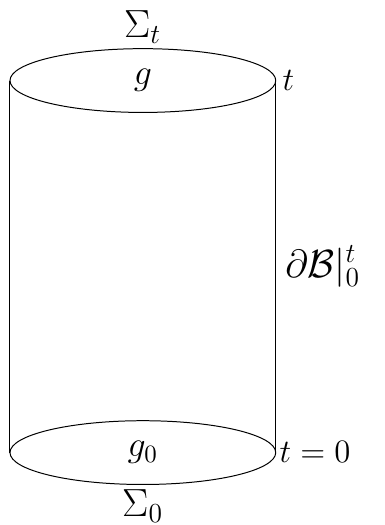
JHEP03(2023)026 (b) The shaded region represents the gravitational (a) This hollow figure represents the partition func- path integral (in eq. (7.7)) over the space-filling tion Z [ g, t ; g bdy ; g 0 , 0] (in eq. (7.6)) of the field the- manifolds whose boundary is ∂ M = Σ t ∪ ∂ B| t ∪ ory on ∂ M = Σ t ∪ ∂ B| t ∪ Σ 0 . The metric on Σ 0 is 0 0 Σ 0 . The bulk metric g satisfies Dirichlet boundary g 0 , on Σ t is g and on ∂ B| t is g bdy . 0 condition (i.e. g | Σ = g 0 , g | Σ = g and g | = ∂ B| t 0 t 0 g bdy ). Figure 9 . By the GHP, the partition function of the field theory (represented by the hollow figure on the left) is equal to the gravitational path integral (represented by the solid figure on the right). The two Cauchy slices Σ and Σ are separated from each other by the boundary time t 0 t